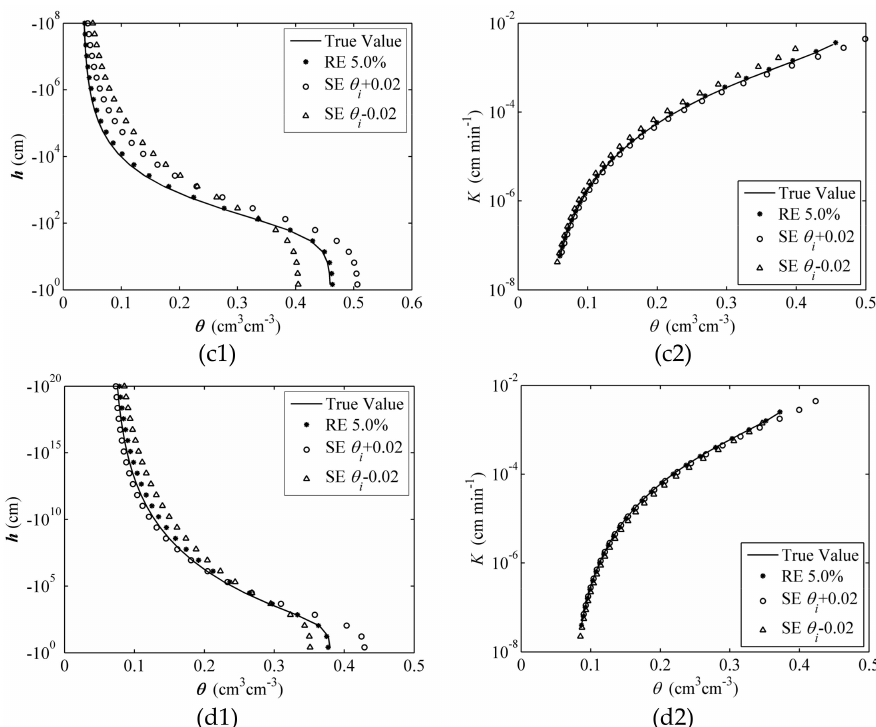
Figure 9. Comparison of SWRCs ( a1 , b1 , c1 , d1 ) and conductivity curves ( a2 , b2 , c2 , d2 ) with random errors (RE) and system errors (SE) for various treatments with objective function ψ ( θ final ): ( a ) Sand; ( b ) Loam; ( c ) Silt; and ( d ) Clay.